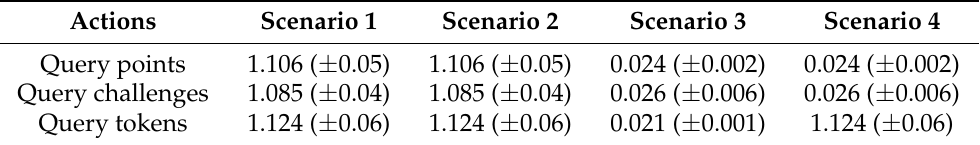
Table 4. Mean response time units for read requests (confidence